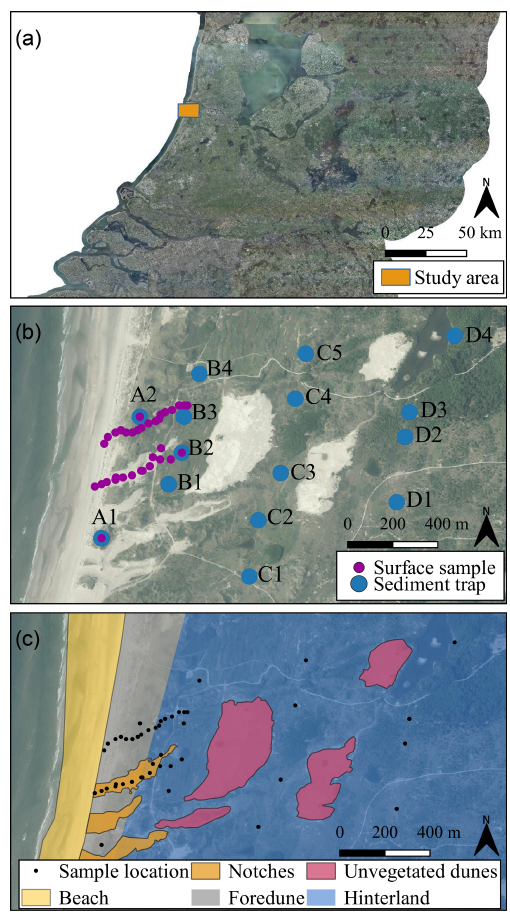
Figure 1. Fieldwork area in the coastal dunes of the Nationaal Park Zuid-Kennemerland. Panel (a) shows the general location of the study area. Panel (b) displays the locations of surface samples and sediment traps. Panel (c) covers the same area and shows subregions based on geomorphologic features. Aerial photograph © PDOK.nl,